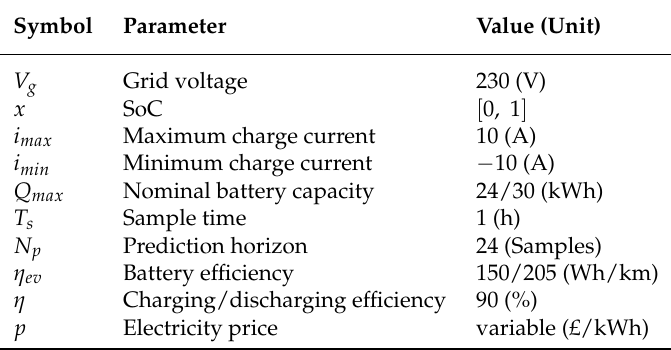
Table 4. Model and optimisation